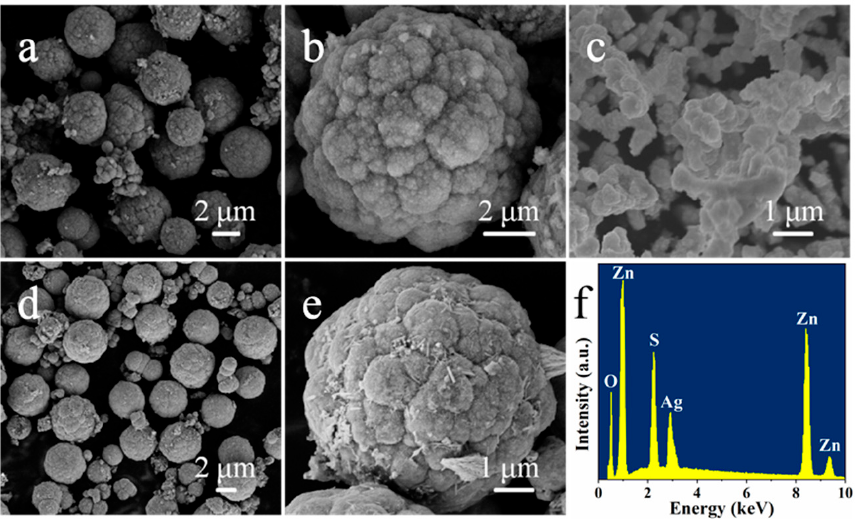
Figure 2. ( a , b ) SEM images of ZnS at different magnifications, ( c ) SEM image of Ag 2 O, ( d , e ) SEM images of ZnS/Ag 2 O composite at different magnifications, ( f ) EDX spectrum of ZnS/Ag 2 O composite.